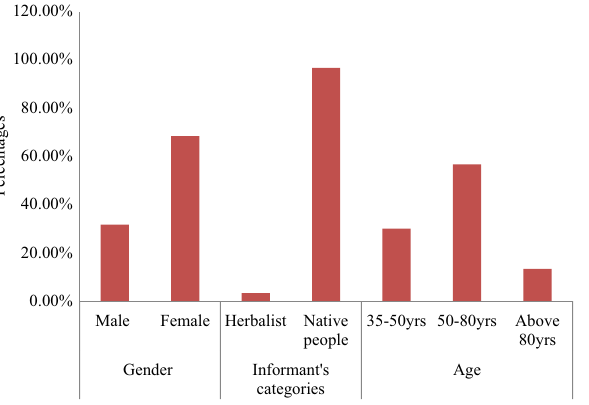
Figure 2: Demographic pro fi le of informants interviewed.